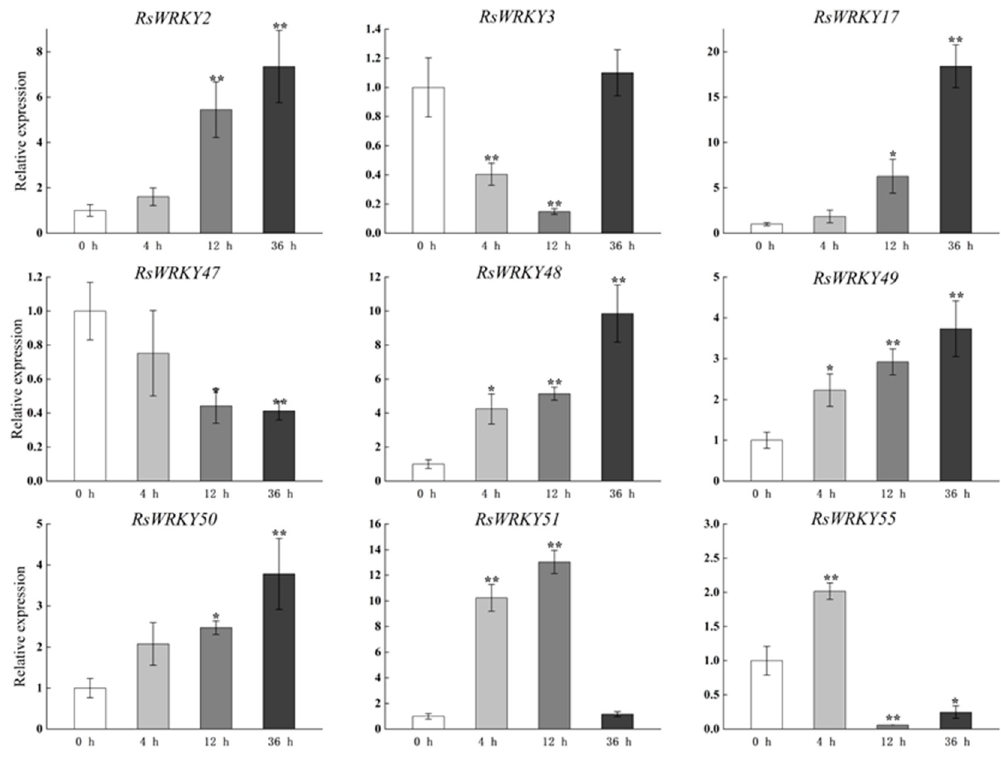
Figure 7. Expression profiles of RsWRKY genes under heat treatment. Gene expression at 0 h was normalized as “1.” Data are mean ± standard deviation (SD), calculated from three biological replicates, and vertical lines represent the standard deviation. * and ** mean significant difference at p < 0.05 and p < 0.01, respectively.